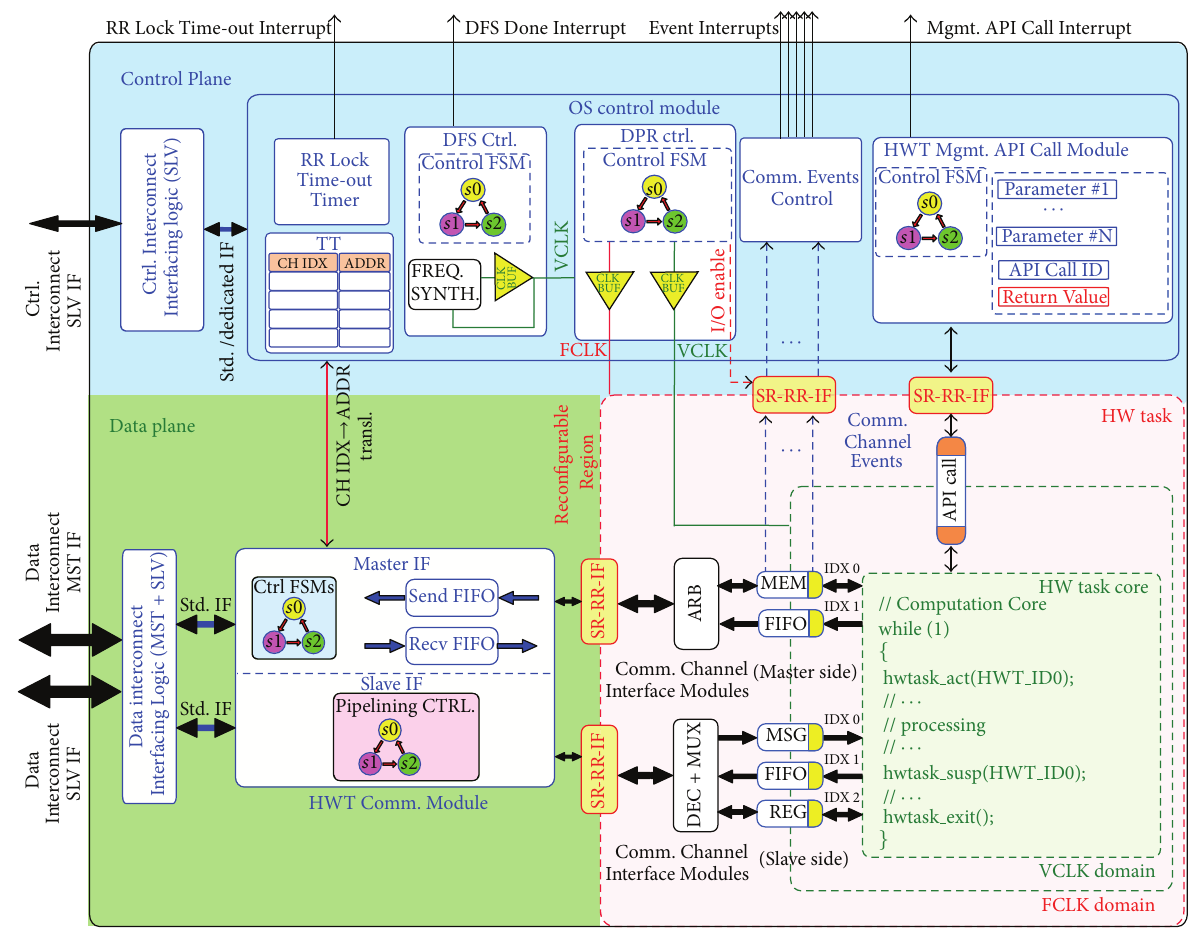
Figure 4: HW Task and HW Task